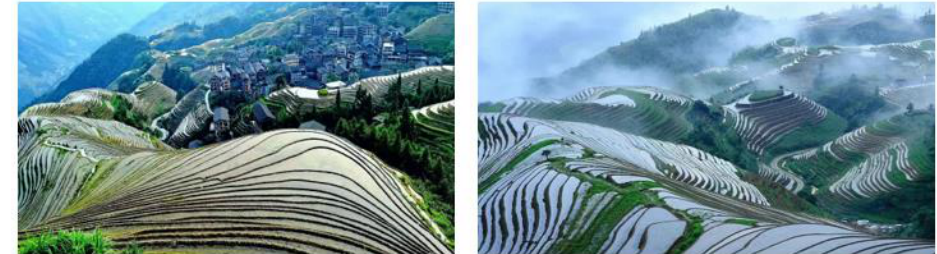
Figure 1. Ping ’ an village and Longji Terraces (Source: Photo provided by villagers). Figure 1. Ping’an village and Longji Terraces (Source: Photo provided by villagers). The Ping’an village comprises traditional pile-dwelling wooden buildings with typ- ical stilt-style architecture and a “zigzag” stone path running through the entire village. Residents of Ping’an village enjoy glutinous rice, bacon dried fish, and sour bamboo shoots, and they have their own elegant ethnic costumes with strong folklore. In terms of beliefs, there are land gods, thunder gods, frog gods, cows, ancestor worship, and Taoist gods, which are mainly related to the cultivation of terraced agriculture. Presently, the village is still dominated by the original Zhuang ethnic group, and participation in the tourism business has become a major source of income for them, with a total of 108 large and small hotels and dwelling houses, two bars, three Zhuang herbal footbaths, six external operators, and two caf é